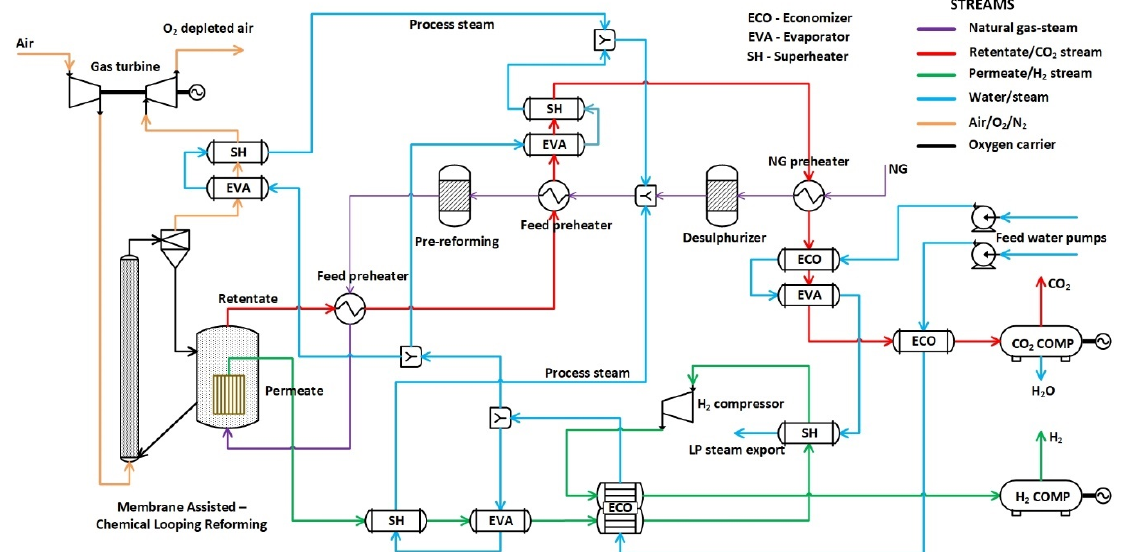
Figure 3. Schematic of membrane-assisted chemical looping reforming (MA-CLR) plant [28].